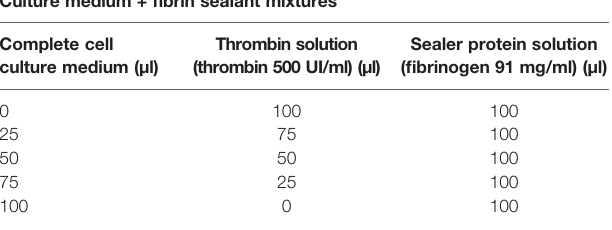
TABLE 1 | Composition of the culture medium (Dulbecco ’ s modi fi ed Eagle ’ s medium) and fi brin sealant mixtures for clotting capability assessment and cell viability